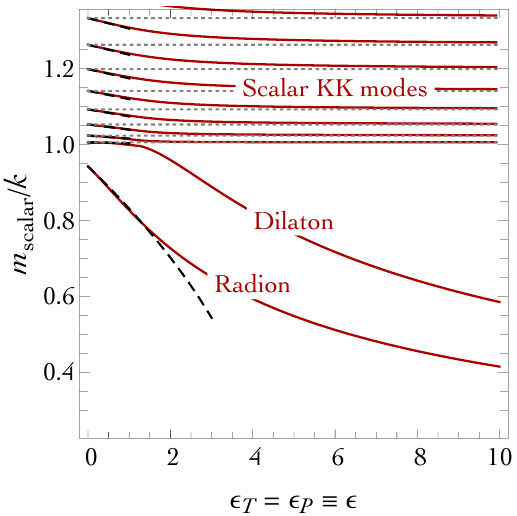
Figure 3 . Scalar KK mode masses as a function of the boundary conditions on the dilaton (cid:12)eld, where (cid:15) = 0 corresponds to rigid boundary conditions (see appendix E for details). The horizontal dotted gray lines correspond to the spectrum m 2 = k 2 + n 2 =R 2 . The dashed black lines correspond n to the analytical approximations discussed in appendix E, eqs.